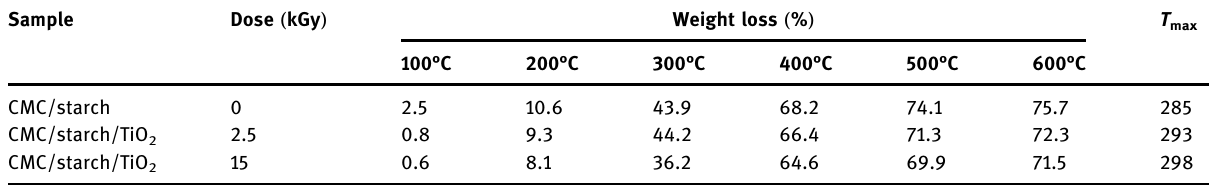
Table 1: Weight loss ( % ) of CMC/starch and CMC/starch/TiO 2 irradiated at 2.5 and 15 kGy at di ff erent decomposition temperatures